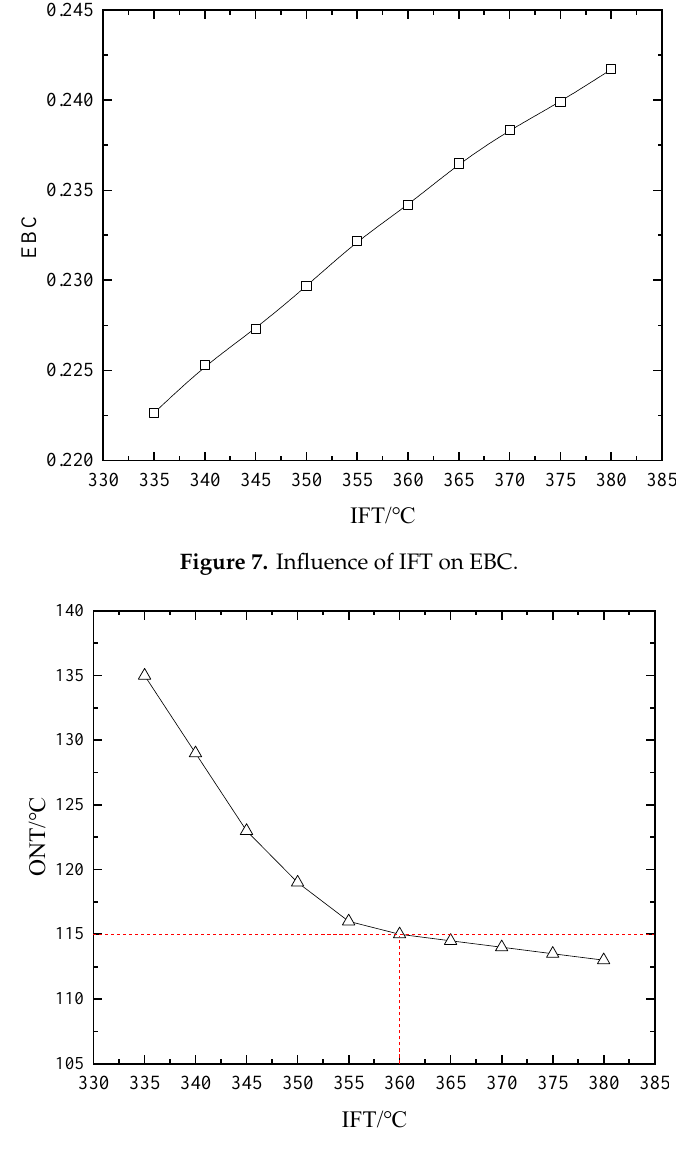
Figure 8. Optimal node temperature (ONT) at different IFT.